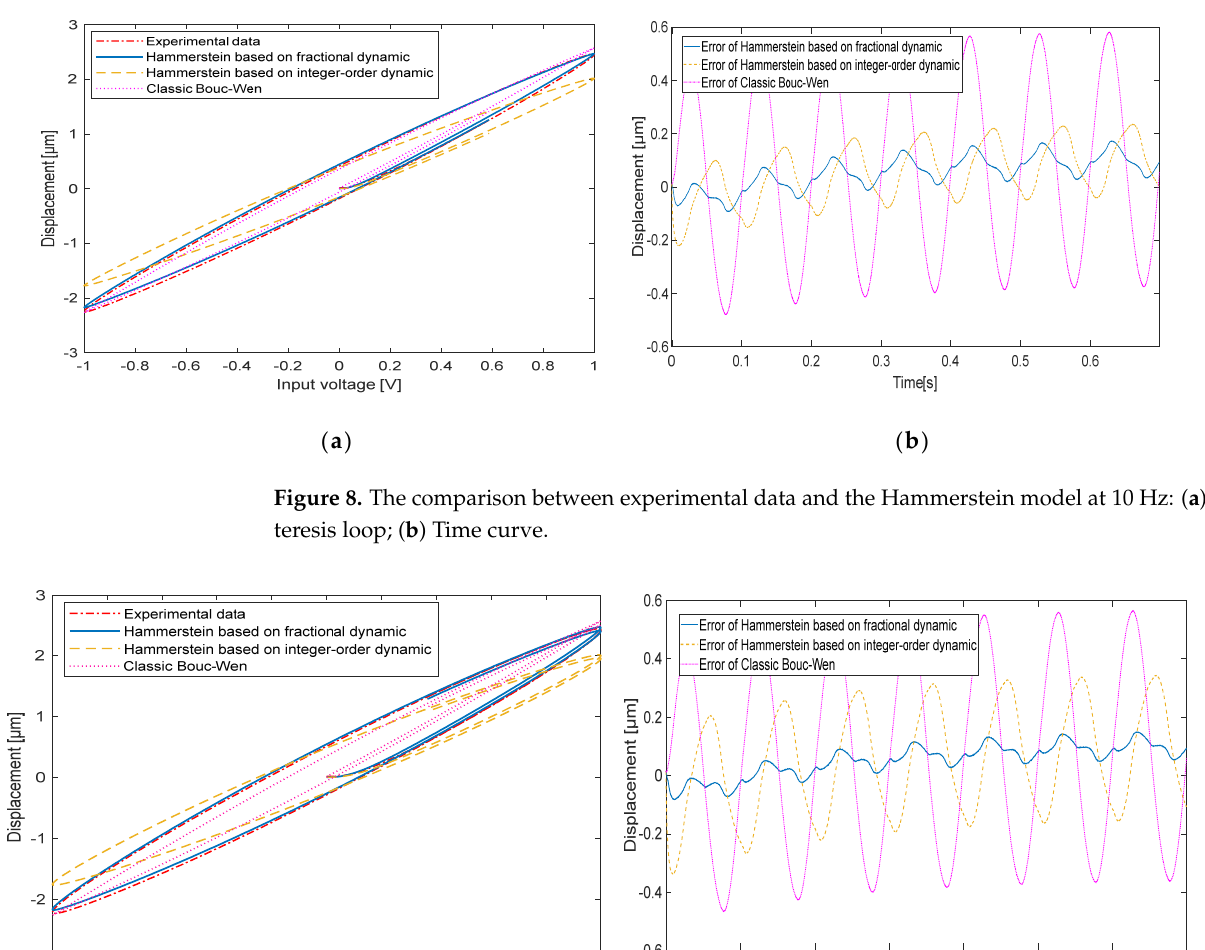
Figure 9. The comparison between experimental data and the Hammerstein model at 20 Hz: ( a ) Hysteresis loop; ( b ) Time curve.